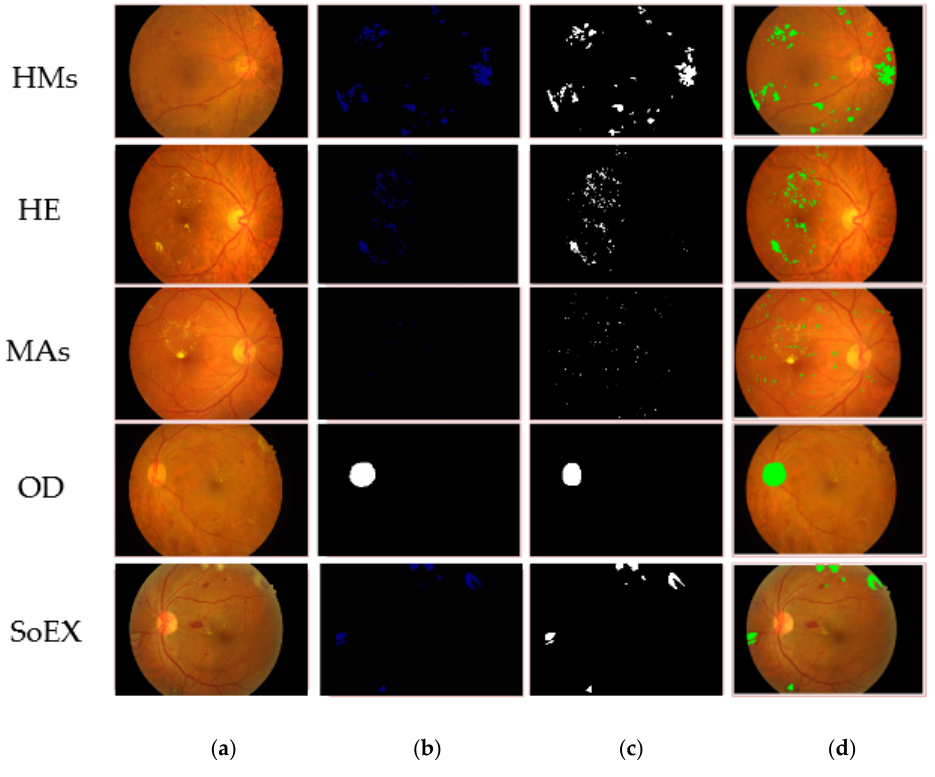
Figure 7. Segmented DR lesions on IDRiD dataset. ( a ) Input image, ( b ) proposed segmentation, ( c ) ground truth image, ( d ) segmented region mapped on the input image.